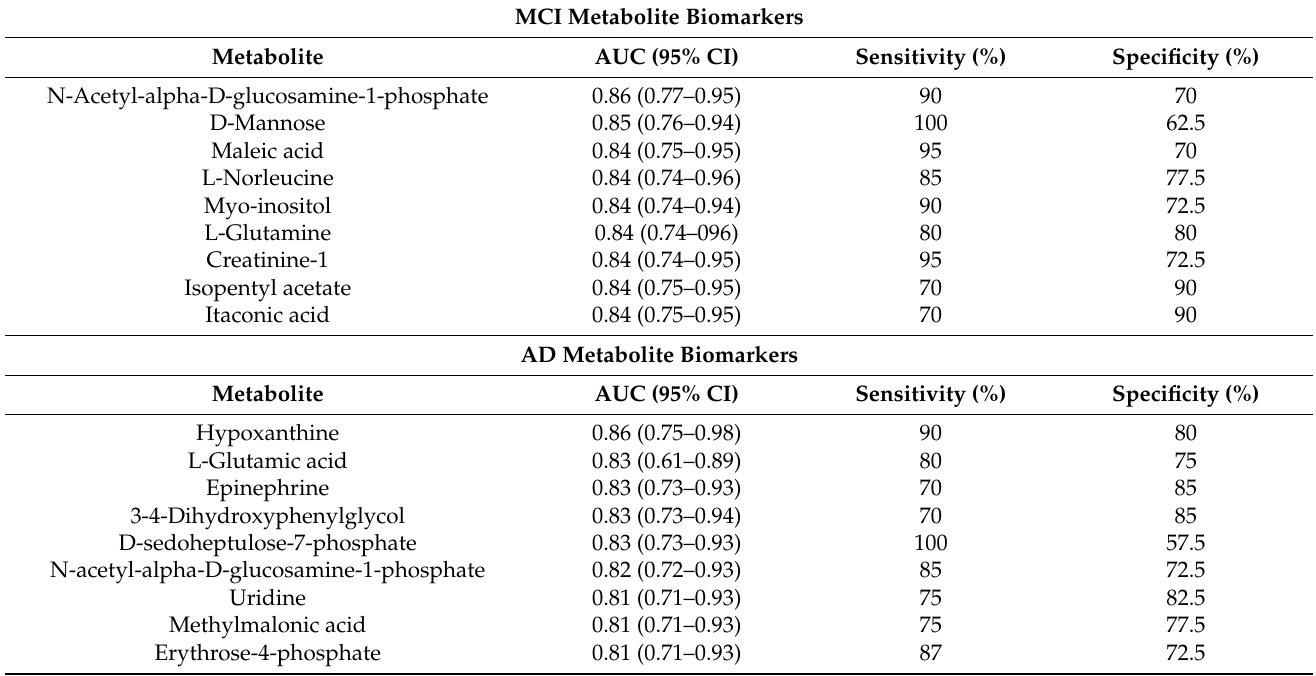
Figure 3. The top 6 protein biomarkers that separated the AD group from the CN group in Table 2. The CN group is shown in black while the MCI and AD groups are shown in blue and red, respectively. Abbreviations: AD, Alzheimer’s disease; CN, cognitively normal; MCI, mild cognitive impairment. Table 3. Top metabolite biomarkers for clinical classification of MCI and AD adjusted for cofounders. MCI Metabolite Biomarkers Metabolite AUC (95%